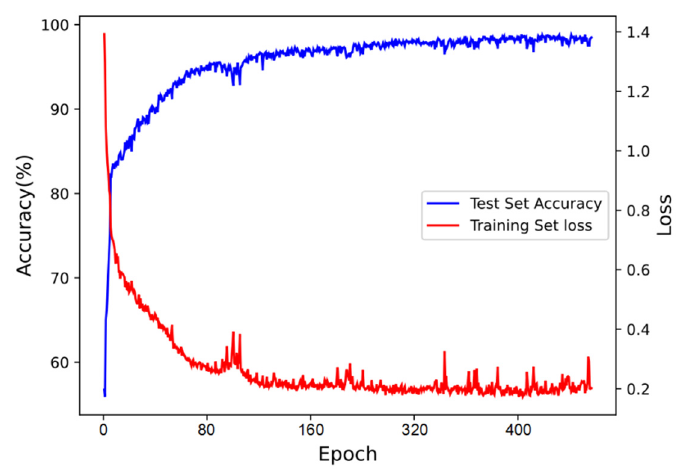
Figure 6. Loss and accuracy curve of ACGAN ‐ SVM ‐ CNN.